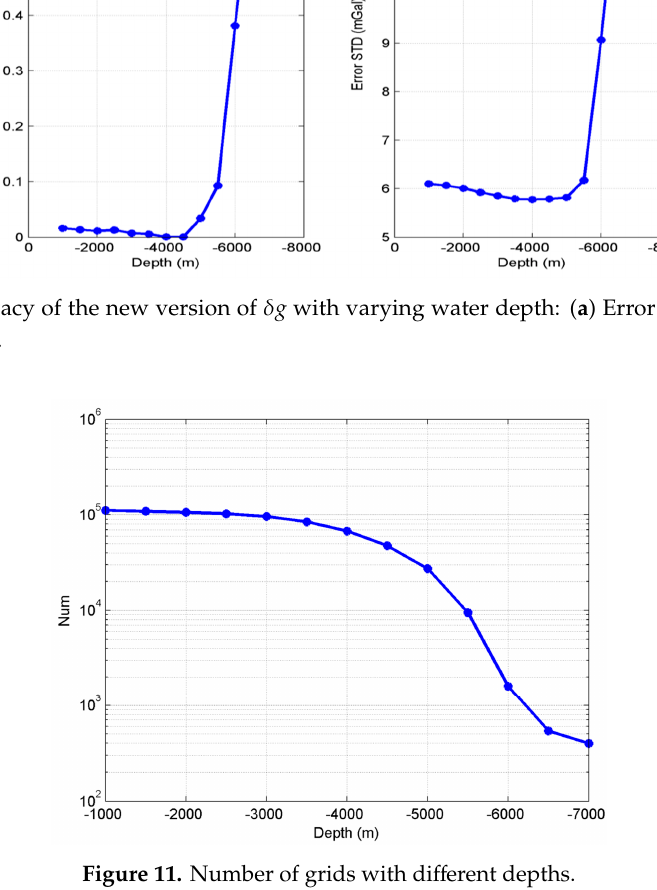
Figure 11. Number of grids with different depths.